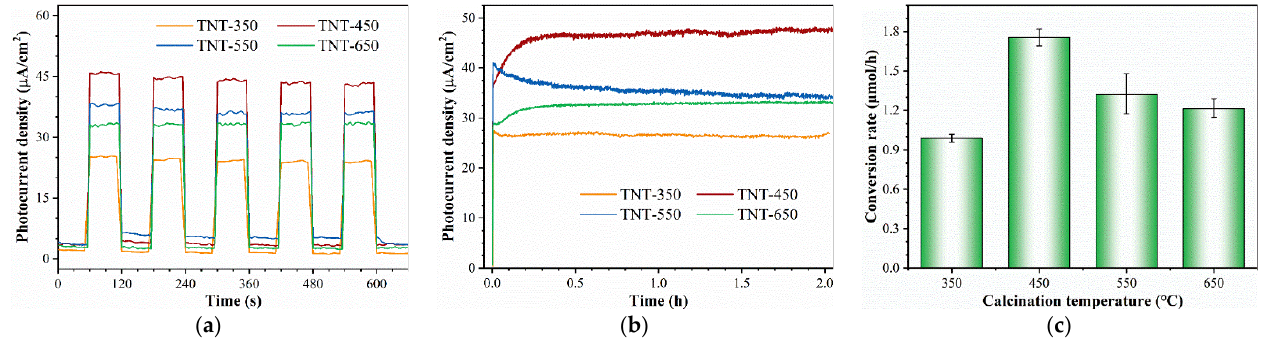
Figure 5. Comparisons of the ( a ) photoresponse behavior, ( b ) photocurrent density during long- term operation and ( c ) vanadium ion conversion rate. (Light intensity: 130 mW/cm 2 , flow rate: 50 μL/min, vanadium ion concentration: 0.1 M).